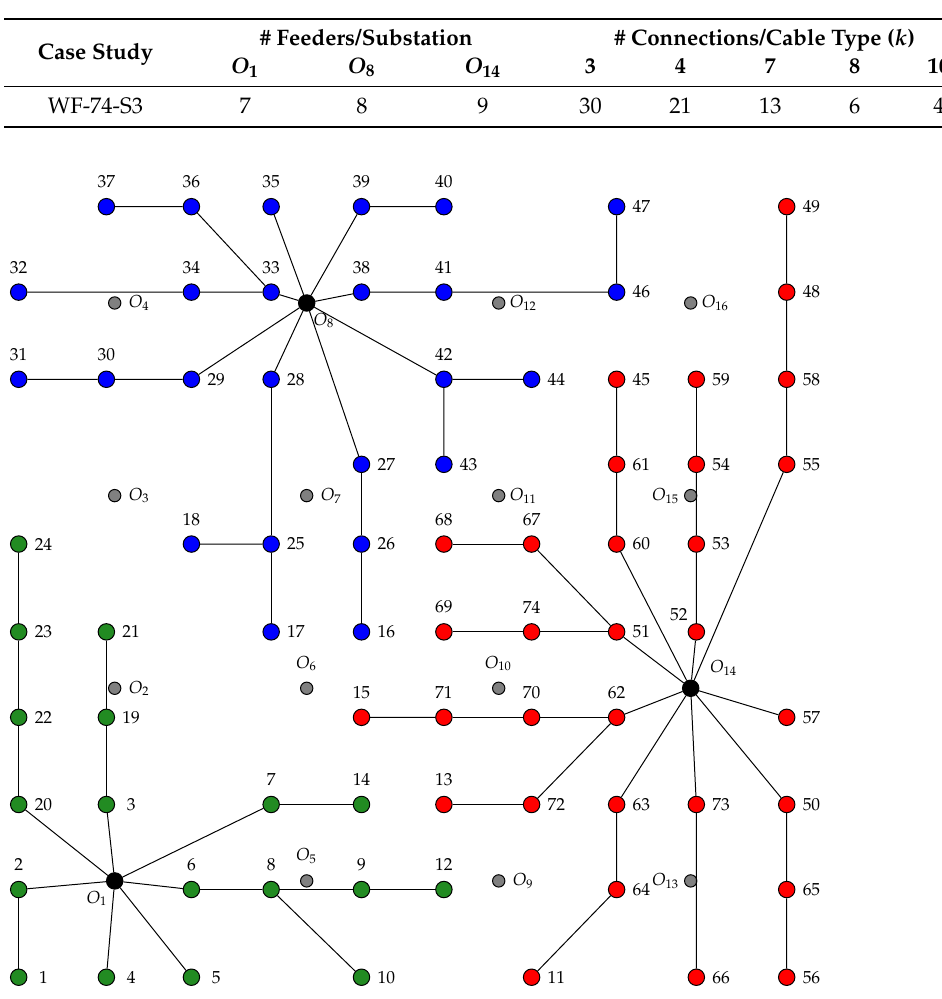
Figure 5. Optimal cable connection layout for the WF-74-S3 wind